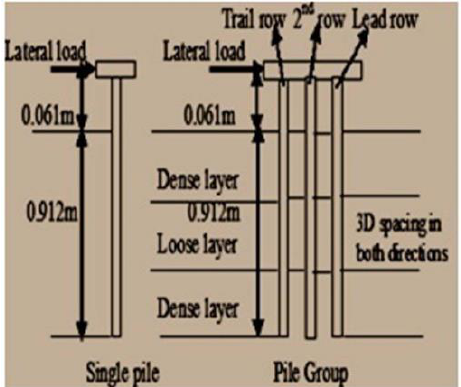
Fig. 4. Layouts of single and pile group.